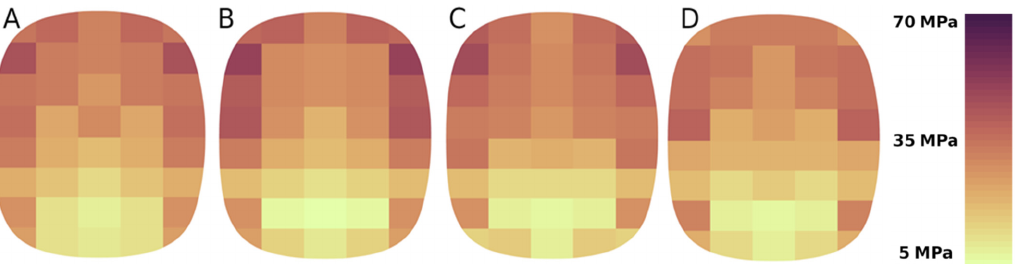
Figure 11. Stresses distribution on the forming cavity surface during briquetting of calcium hydrox- ide for the circumferential speed of the rollers: ( A )—0.1 m/s, ( B )—0.15 m/s, ( C )—0.2 m/s, ( D )—0.3 m/s.